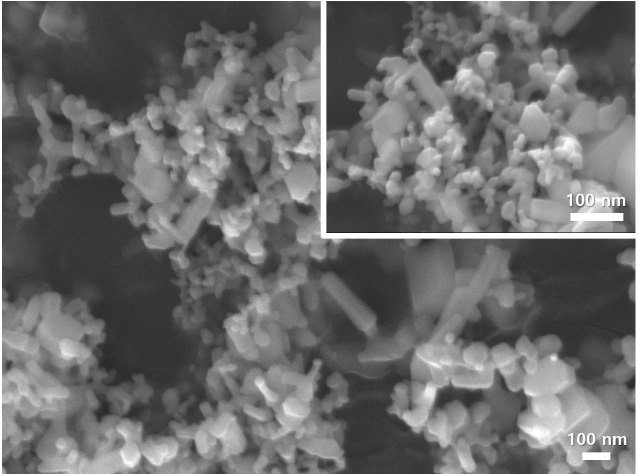
Figure 2. Scanning electron microscopy images of ZnO NPs at magnifications of 100,000× ( top ) and 50,000× ( bottom ).